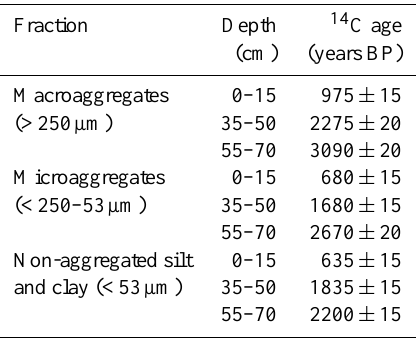
Table 5. Conventional radiocarbon ages for investigated fractions for different depths at the depositional